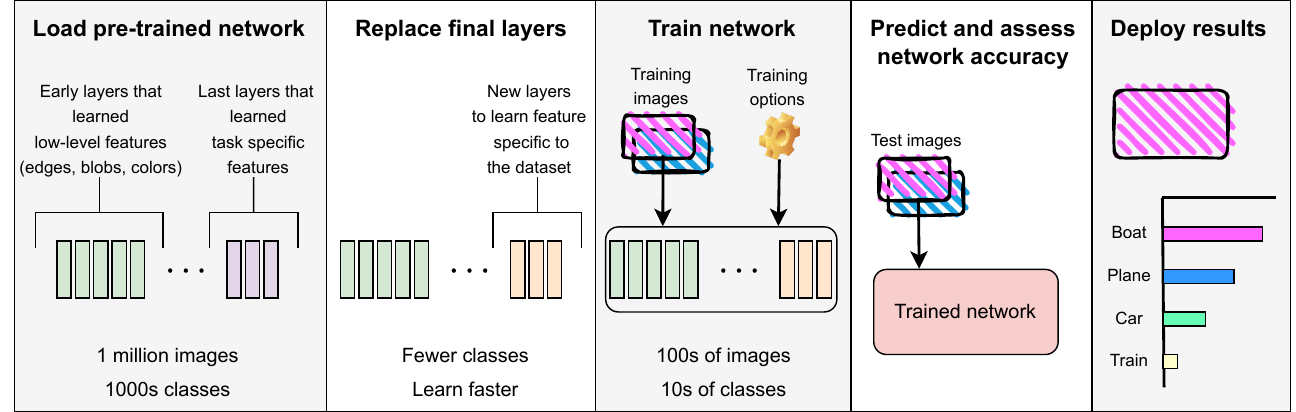
Figure 4. Transfer Learning using